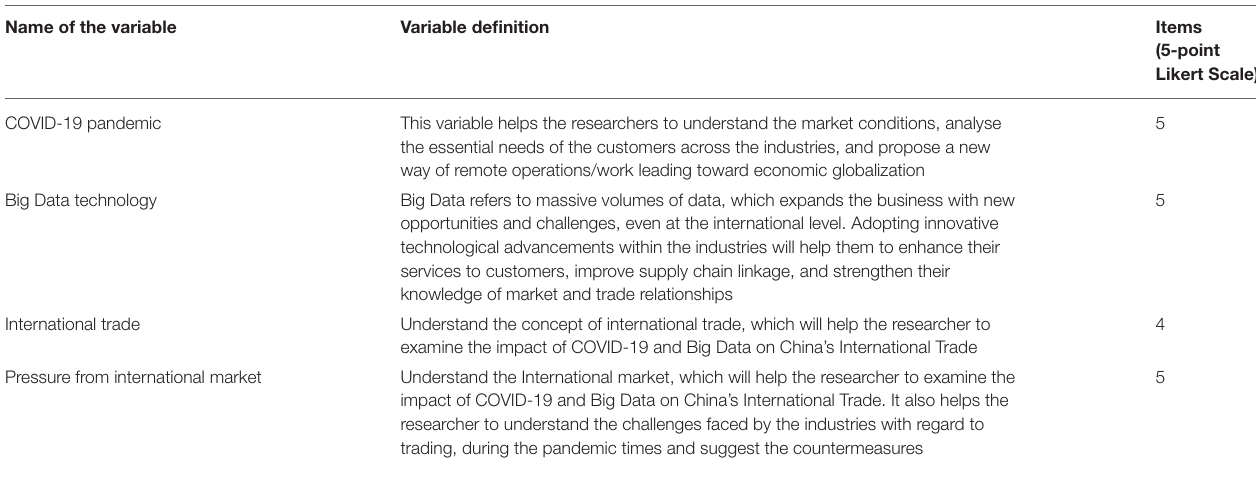
TABLE 2 | Variables of the study.